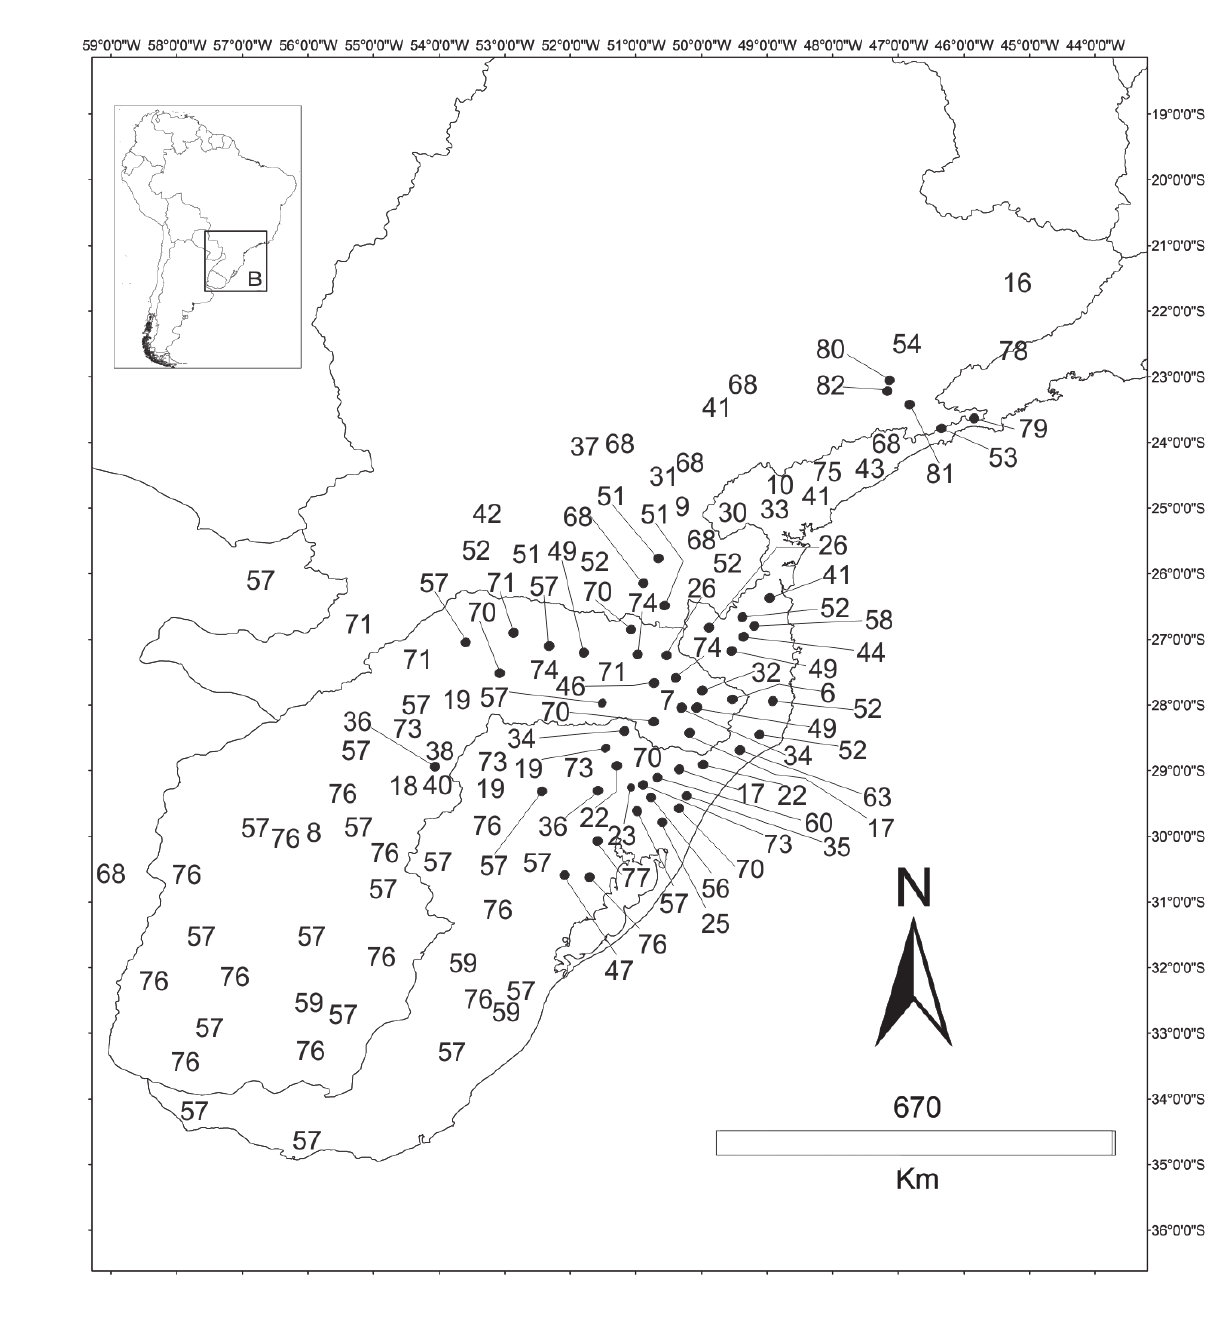
Figure 3. Distribution of Aegla Leach, 1820 in Brazil and Uruguay (see Tab. 1 for the corresponding species number). In areas with less species diversity, we used a larger font size to facilitate the localization in the map. However, where diversity is high, to avoid overlapping the numbers, we reduced the font size, and if necessary we used a point with a line indicating the respective